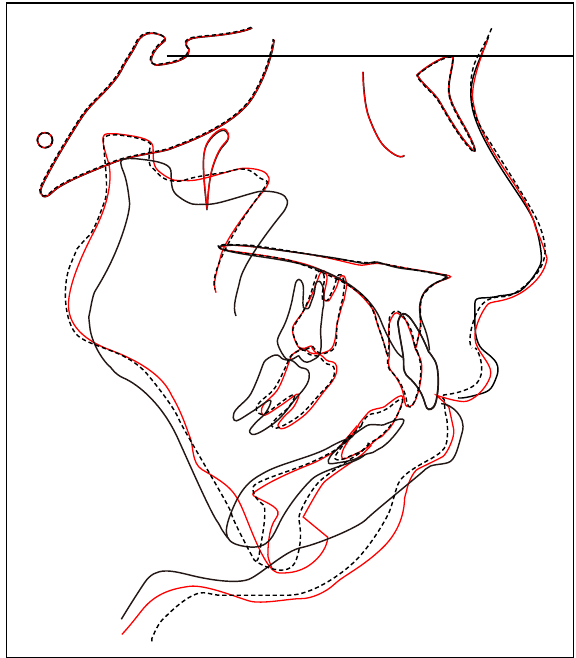
Figure 6. Superimposed lateral cephalometric tracings on the SN plane at S; pretreatment (solid line), post-active treatment (red line) and post- five-year retention (dotted